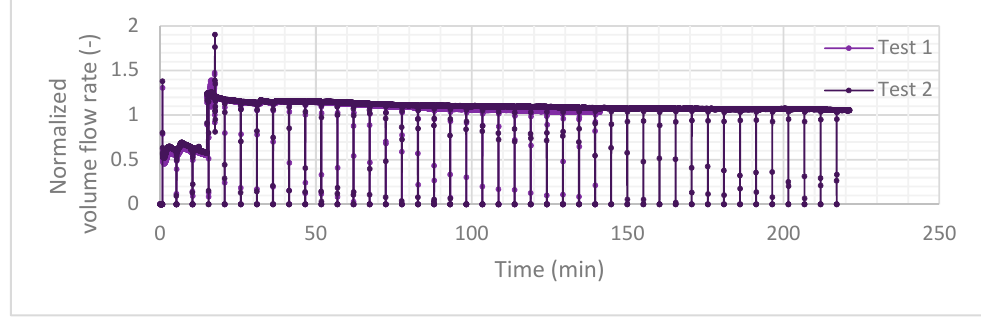
Figure A8. Normalized air volume flow rate trend at a thermostatic temperature of − 30 °C during the two repetitions.